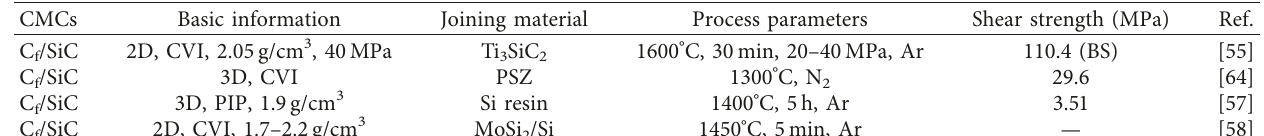
Table 5: Self-joining of C f /SiC composites using inorganic filler (BS